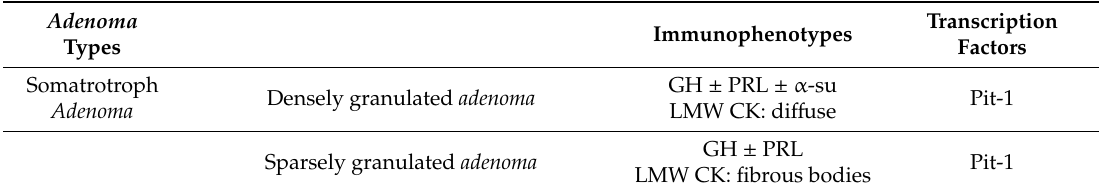
Table 1. WHO 2017 Classification of Pituitary Adenomas, adapted from